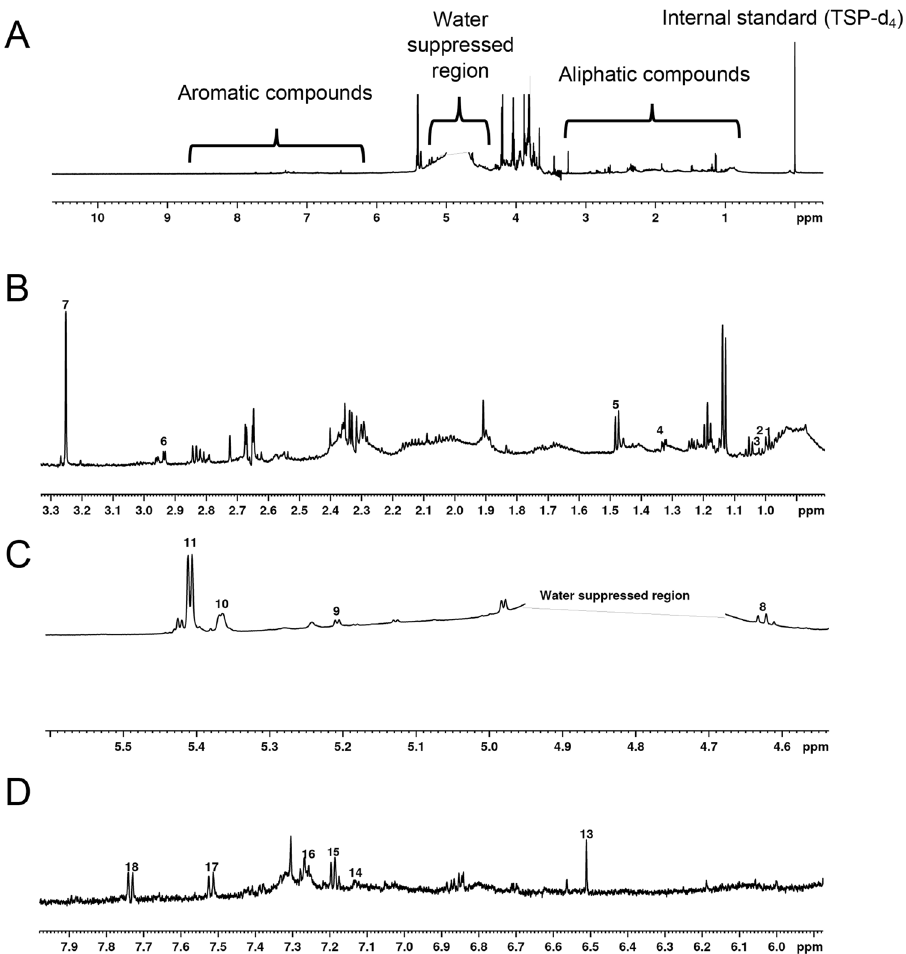
Figure 6. Representative 1D 1 H NMR spectrum of whole wheat flour (Kharkof) showing full spectrum ( A ), amino acids ( B ), carbohydrates ( C ), and aromatic ( D ) spectral regions. The name of the compounds represented by each number are presented in Table